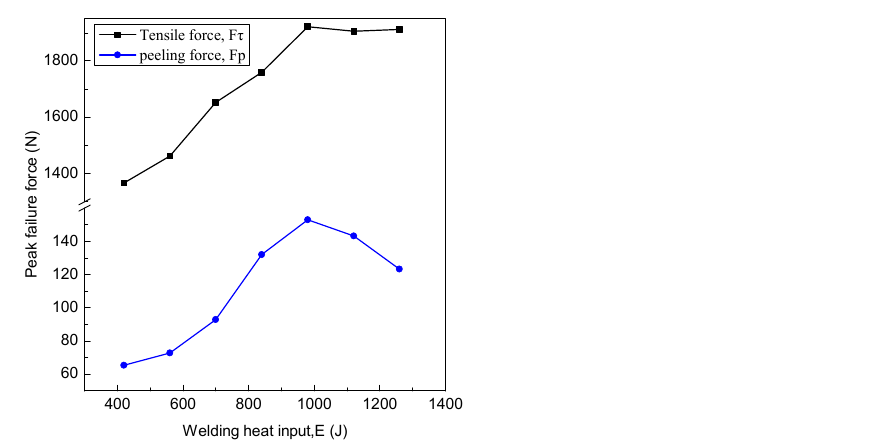
Figure 7. Metallographic diagram of the joints with different welding heat inputs: ( a ) 700 J; ( b ) 980 J; ( c ) 1260 J.